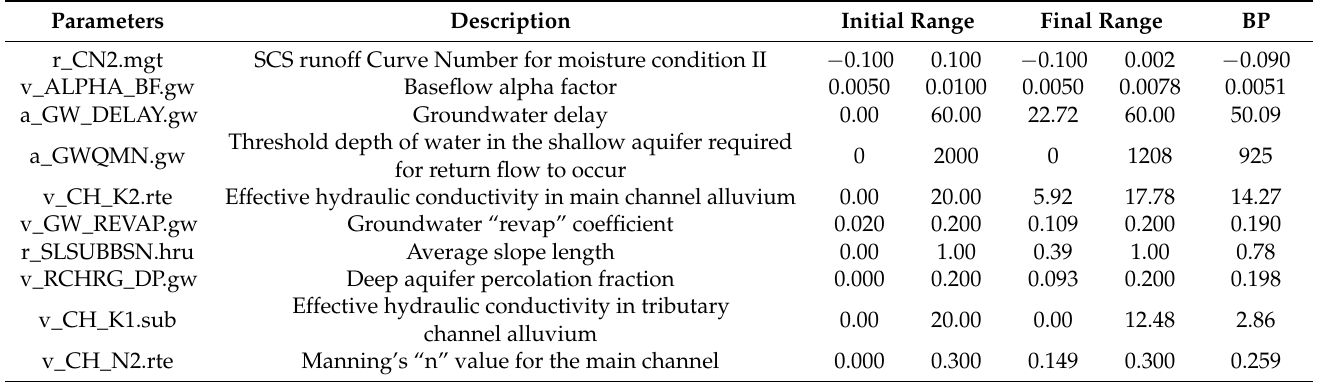
Table 3. Parameters used to calibrate the SWAT model with OP and CRU climatological data and their initial and final ranges, and best parameters (BP).